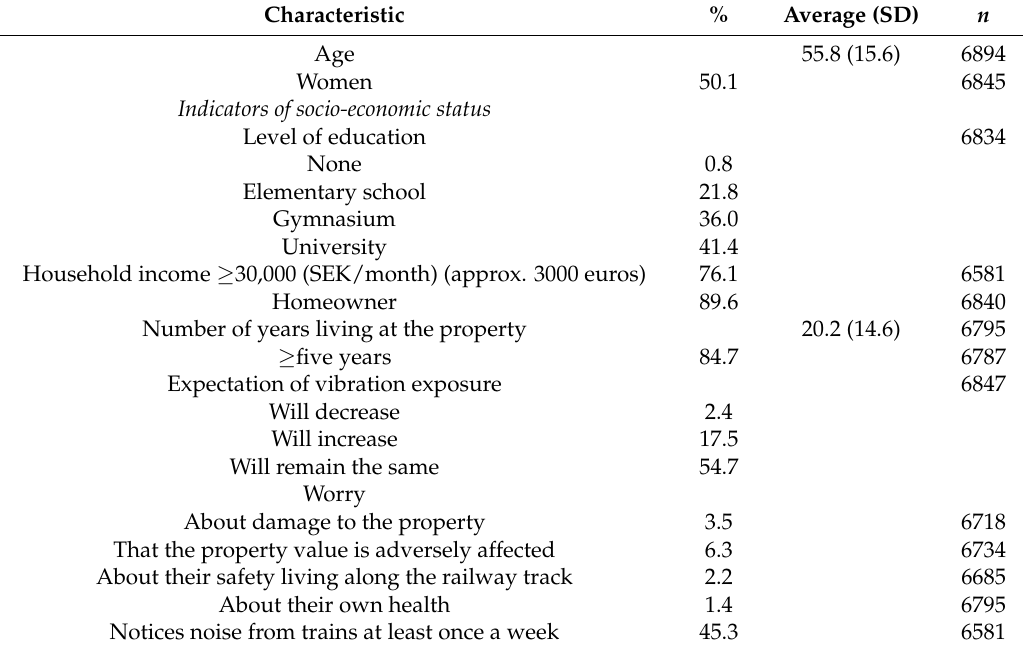
Table 1. Descriptive statistics of the participants who completed a questionnaire ( n = 7679).